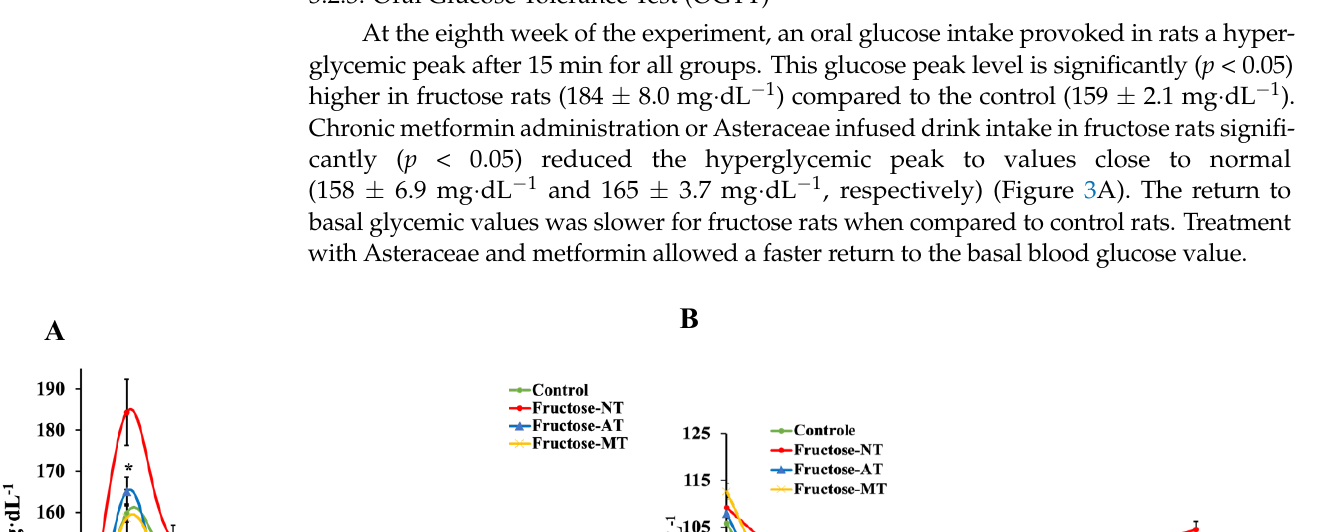
Figure 4. Systolic arterial blood pressure at the end of the experiment (week 8). Different letters show significant differences at ( p < 0,05).